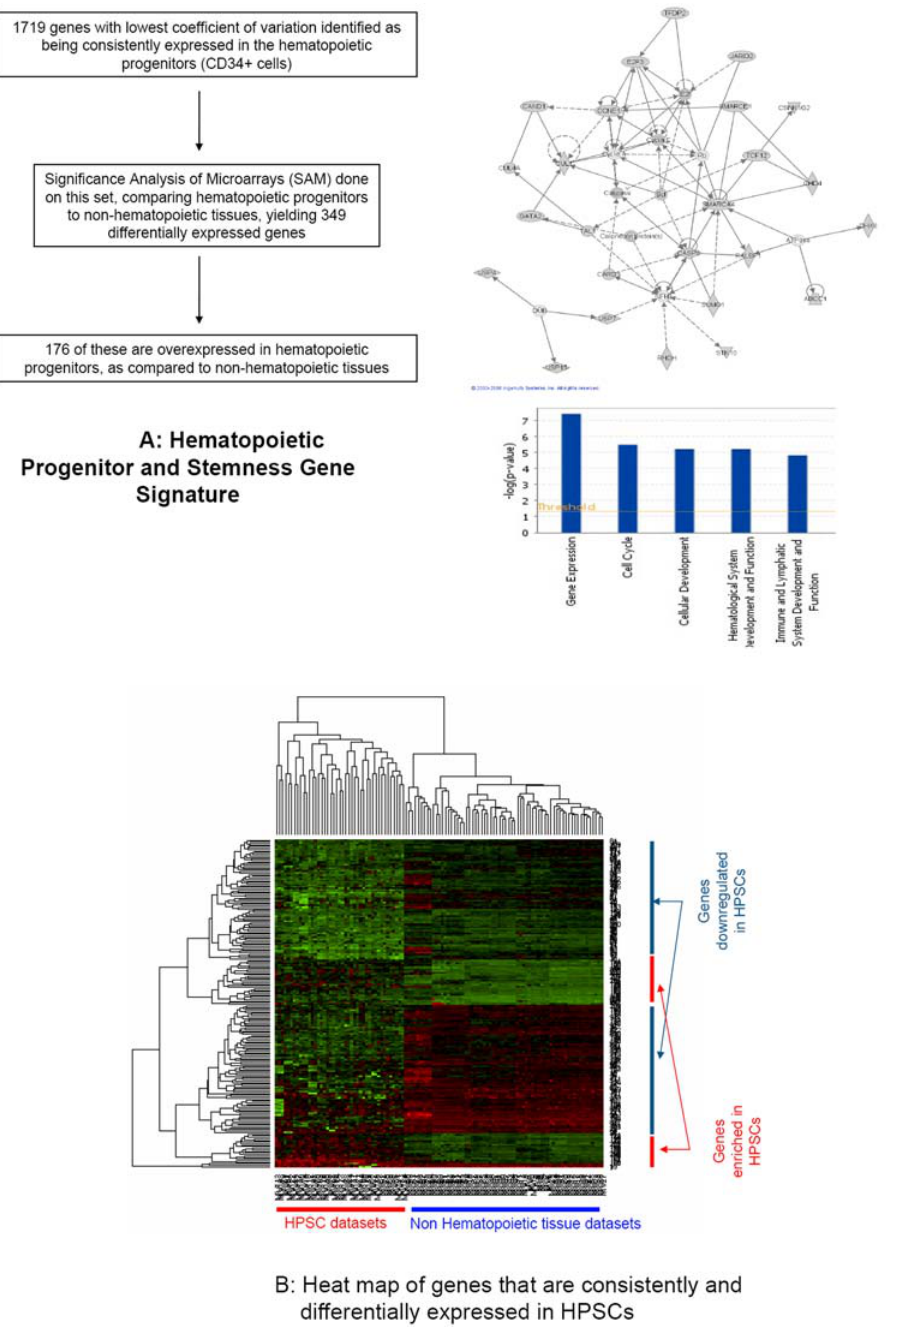
Figure 5. A: ‘‘Stemness genes’’. 349 UniGene IDs were identified as being consistently expressed amongst the normal hematopoietic cells and differentially expressed between hematopoietic and non-hematopoietic cells. Genes enriched in hematopoietic progenitor and stem cell datasets were involved in important functional pathways in the cell, including drug metabolism, hematological system development, cell signaling and cancer and cell death, as shown in the bar graph alongside. One such network is shown, which includes the GATA2, Cyclin E and SMARCE1 genes. B: Heatmap of ‘‘stemness’’ genes. 349 Unigene IDs were identified as being consistently expressed amongst the normal hematopoietic cells and differentially expressed between hematopoietic and non-hematopoietic cells. Out of these, 176 genes were enriched in HSC datasets when compared to other tissue types.